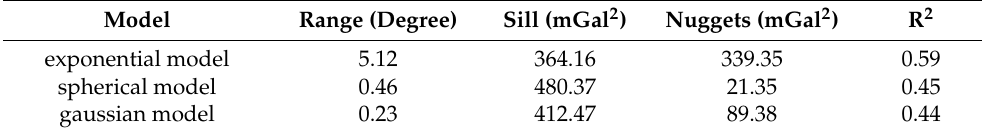
Table 1. Fitting results of three theoretical variograms models in horizontal direction.